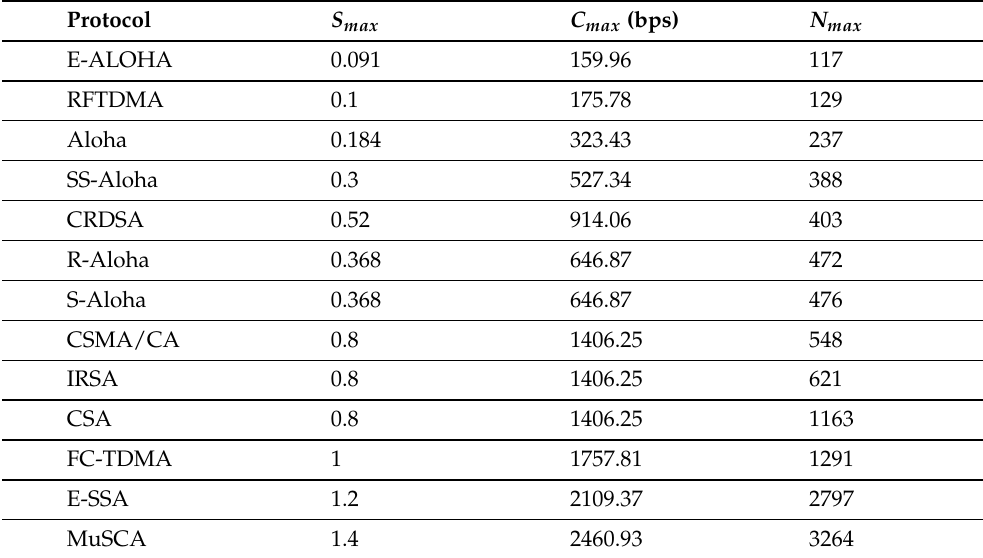
Table 4. Maximum number of nodes N max allowed within the footprint of the satellite simultaneously.